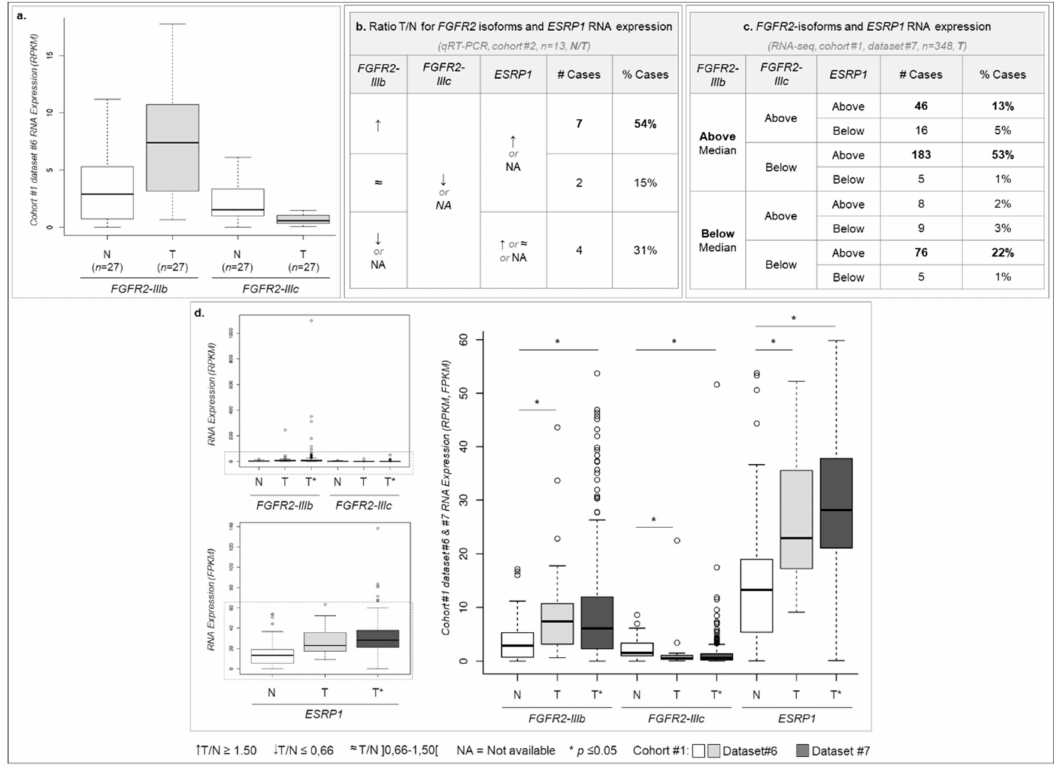
Figure 2. FGFR2 isoforms and ESRP1 RNA expression status across several cohorts. ( a ) Cohort #1 dataset #6 RNA expression for 27 paired normal (white) and tumor (grey) samples for the specific exons FGFR2-IIIb and FGFR2-IIIc . ( b ) Table with the number and percentage of cases with a given RNA expression profile for FGFR2-IIIb , FGFR2-IIIc and ESRP1 in 13 GC paired cases from cohort #2, determined by qRT-PCR. Upwards arrow for cases where the expression ratio (T / N) is equal or above 1.50, downwards arrow for cases with expression ratio below 0.67, and ‘~’ when the expression ratio is between 0.67 and 1.5. NA stands for not available. ( c ) Table with the number of cases with a given RNA expression for FGFR2-IIIb , FGFR2-IIIc and ESRP1 in 348 GC samples (unpaired) from cohort #1 dataset #7, determined by RNA-seq . Due to the absence of paired normal samples in cohort #1 dataset #7, the median RPKM value for each transcript in cohort #1 dataset #6 normal samples was used as threshold to determine the number of cases with RNA expression above or below it in cohort #1 dataset #7. Median RNA expression values calculated for normal stomach samples were: FGFR2-IIIb = 2.89; FGFR2-IIIc = 1.53; ESRP1 = 13.26. ( d ) Boxplot representation of the RNA expression of the specific exons for FGFR2-IIIb and FGFR2-IIIc isoforms (RPKM) and for the canonical ESRP1 transcript (FPKM) for the paired normal and tumor cases from cohort #1 dataset #6 (N and T) and the unpaired tumor cases from cohort #1 dataset #7 (T*). The larger boxplot is a zoom in from the region represented with dotted rectangles in the smaller boxplots. Asterisks stand for p -value ≤ 0.05. Of notice, ESRP1 RNA expression data are the same as represented in Supplementary Figure